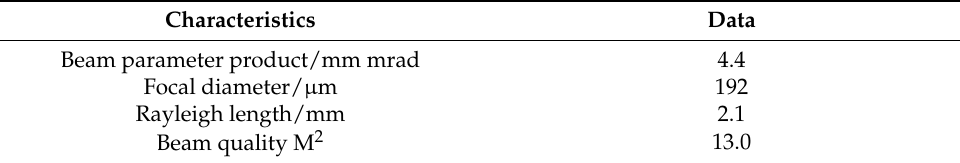
Table 2. Characteristics of the beam source.